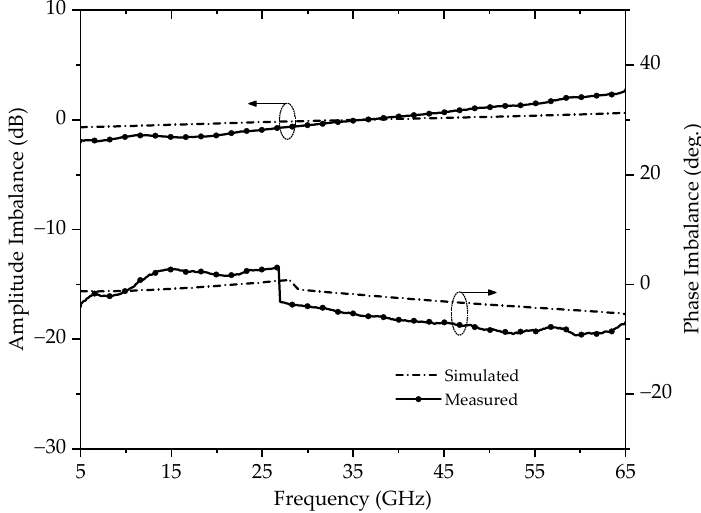
Figure 11. Simulated and measured amplitude and phase imbalance.